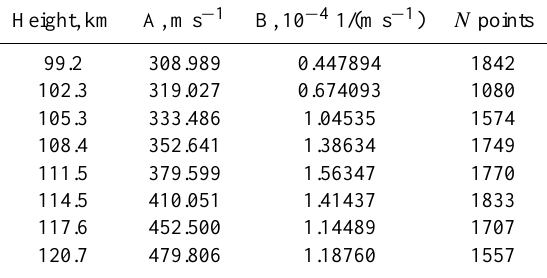
Table 1. Periods of EISCAT CP1 observations considered in this study.